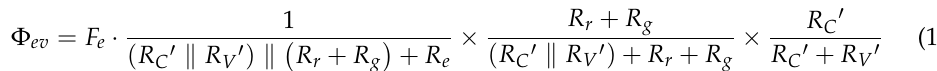
ev . It is known from